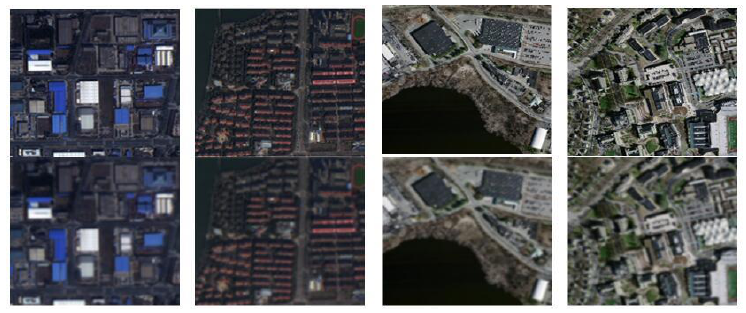
Figure 6. Gaussian filtering result.